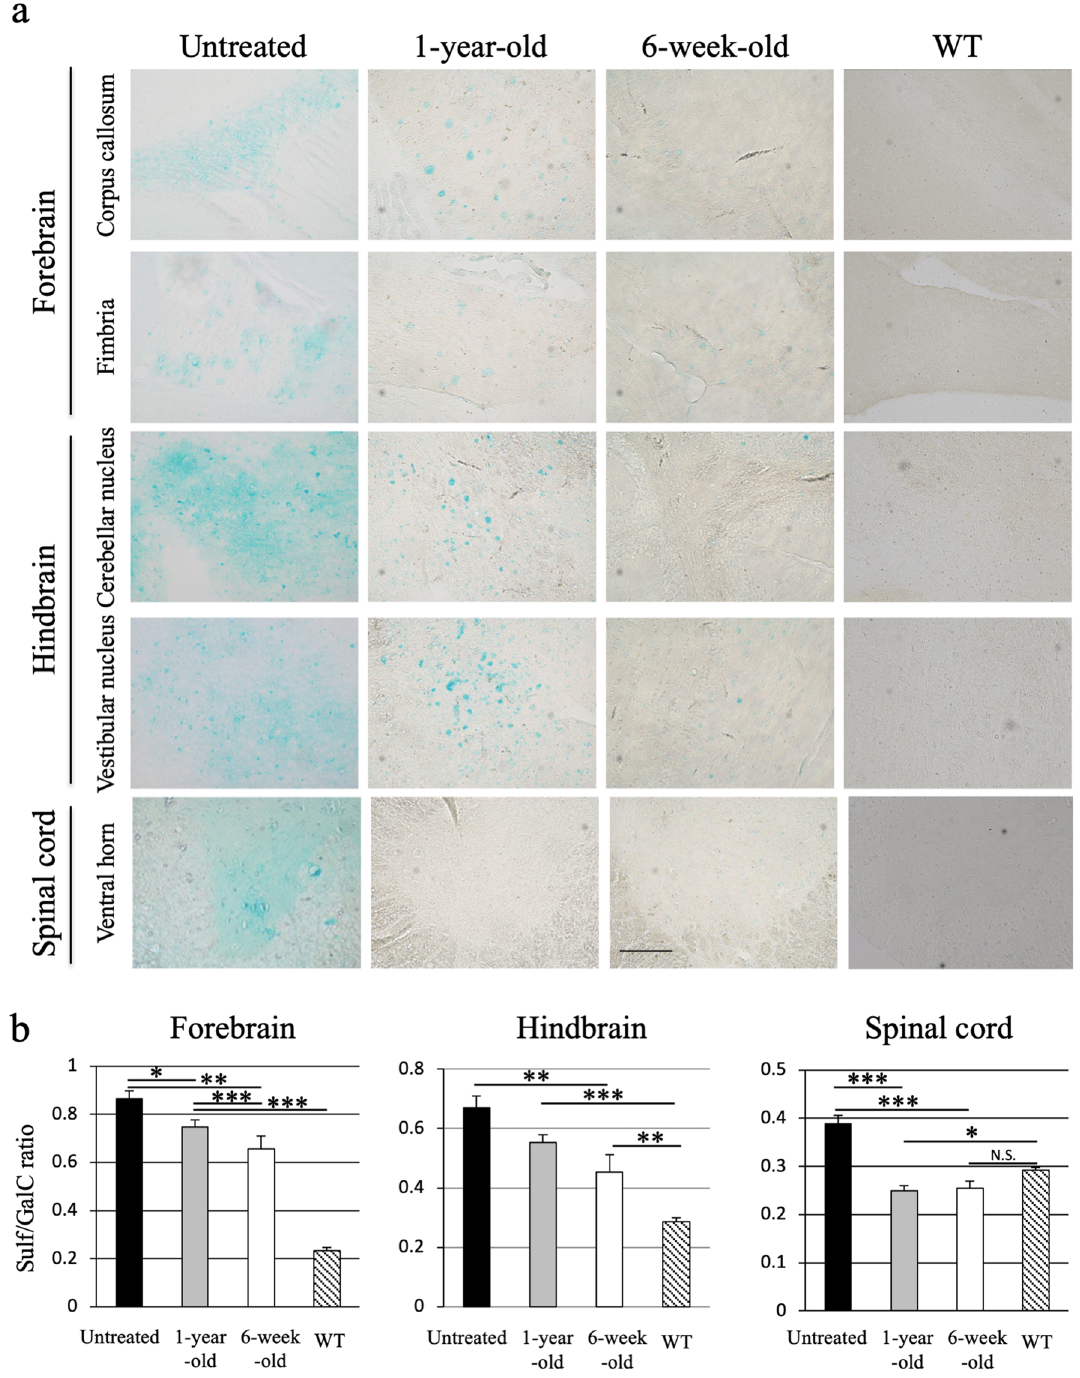
Figure 4. Correction of sulfatide storage in the brain and spinal cord. ( a ) Alcian blue staining of sulfatide in the brain and the spinal cord of 15-month-old MLD mice left untreated or treated with AAV9/ARSA at 1 year or 6 weeks of age. Bar: 200 μM. ( b ) Sulfatide content detected using thin layer chromatography. Ratios of sulfatide (Sulf) to galactosylceramide (GalC) content (Sulf/GalC ratio) in the brain and cervical spinal cord of MLD mice left untreated (closed bars, n = 5), MLD mice treated at 1 year (gray bars, n = 5) or 6 weeks of age (open bars, n = 4), and wild-type (WT) mice (diagonally hatched bars, n = 8). * P < 0.05, **p < 0.01, ***p <